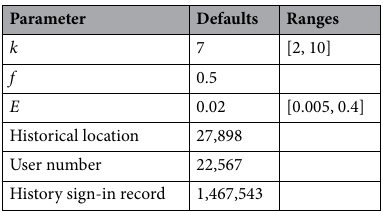
Table 4. Experimental parameters configuration